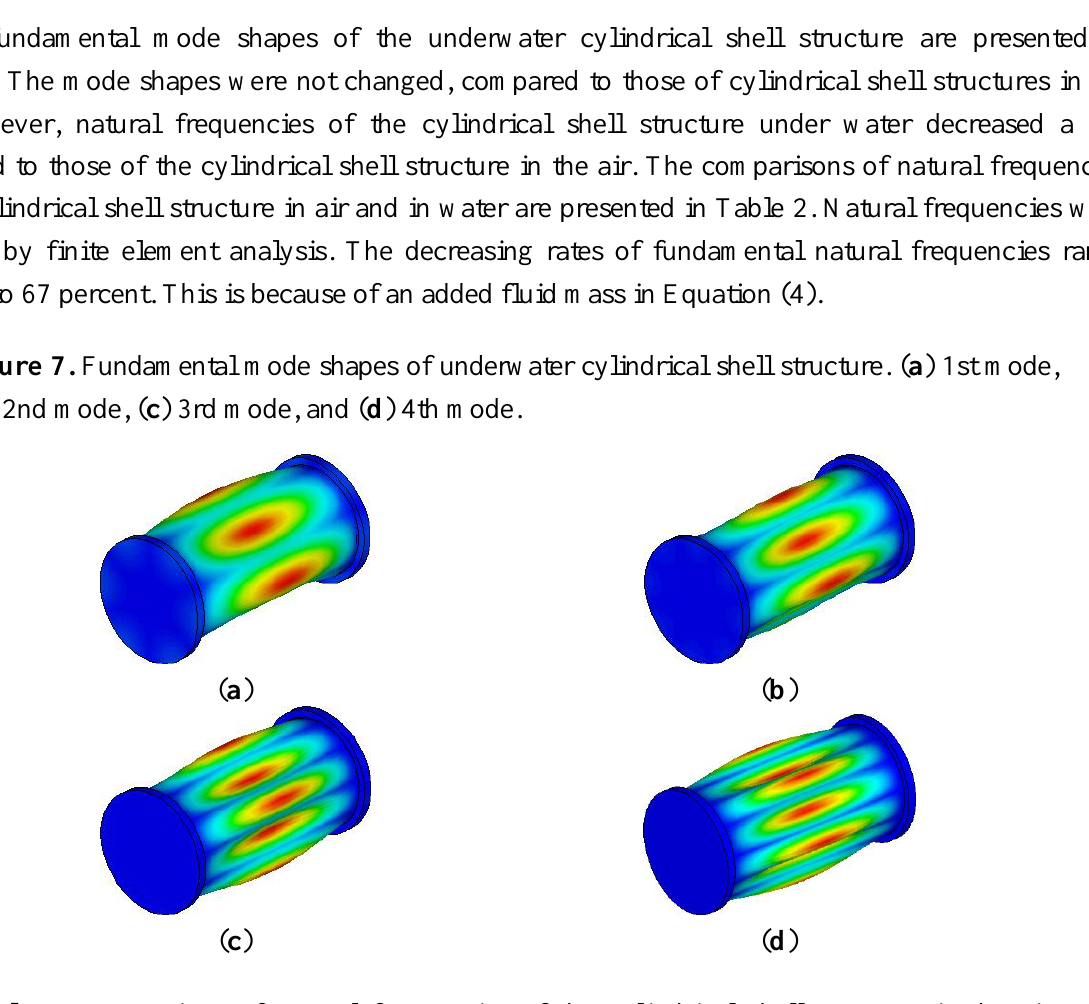
Table 2. Comparison of natural frequencies of the cylindrical shell structure in the air, and